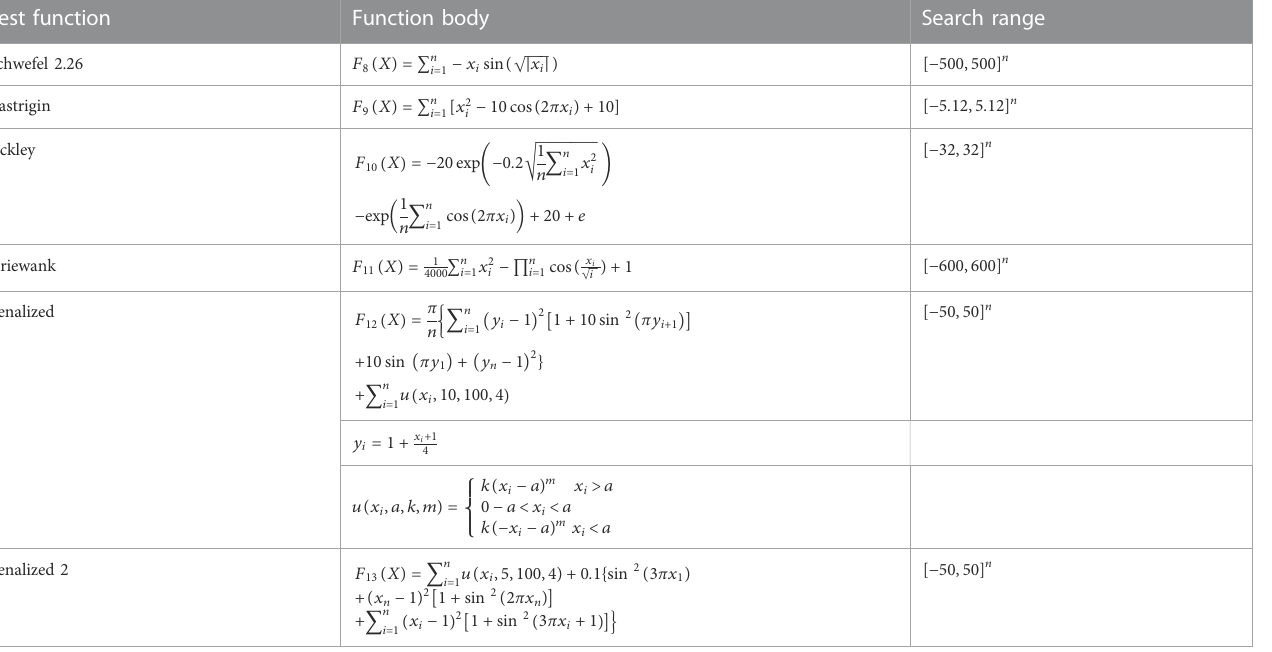
TABLE 2 Multimodal test functions. Test function Function body Search